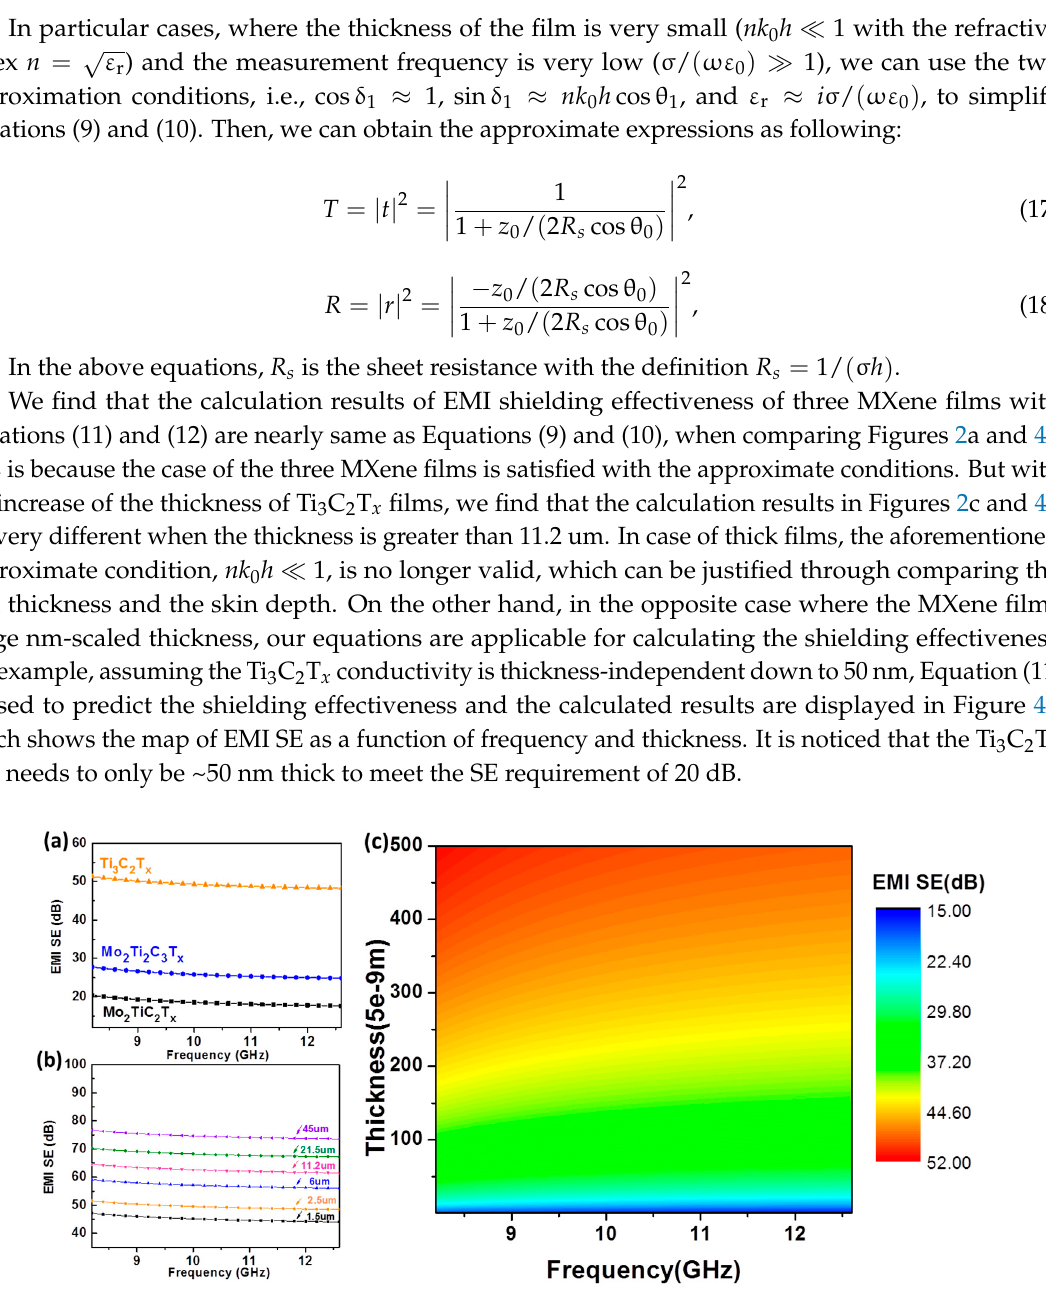
Figure 4. ( a ) Calculation of EMI shielding effectiveness of three MXene films by using approximate expressions, Equations (17) and (18), where thickness and conductivity are obtained from Reference [8]. ( b ) Calculation of EMI shielding effectiveness of Ti 3 C 2 T x films with conductivity and different thickness obtained from Reference [8], which is completed by using approximate expression, Equations (17) and (18). ( c ) The calculated color map of EMI SE as a function of frequency and thickness.